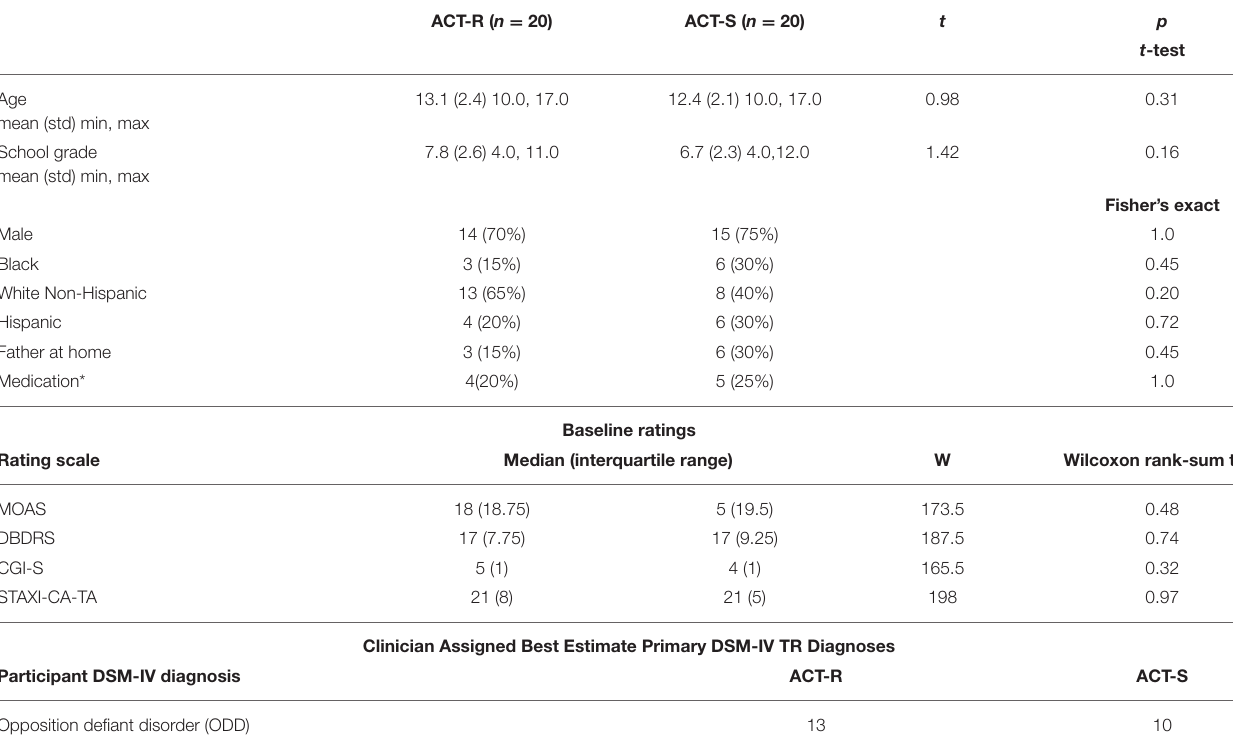
TABLE 1 | Demographic and clinical characteristics of treatment